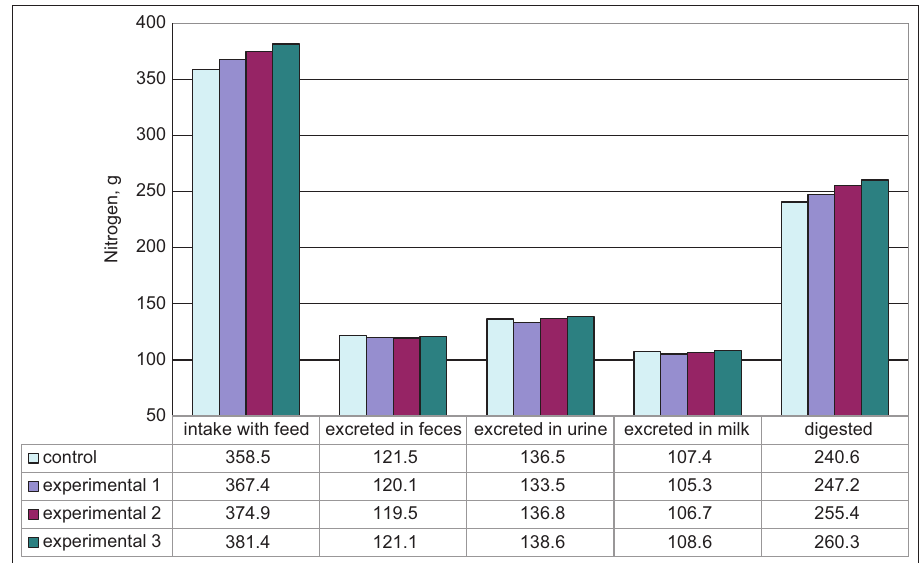
Figure-1: Nitrogen balance in cows,